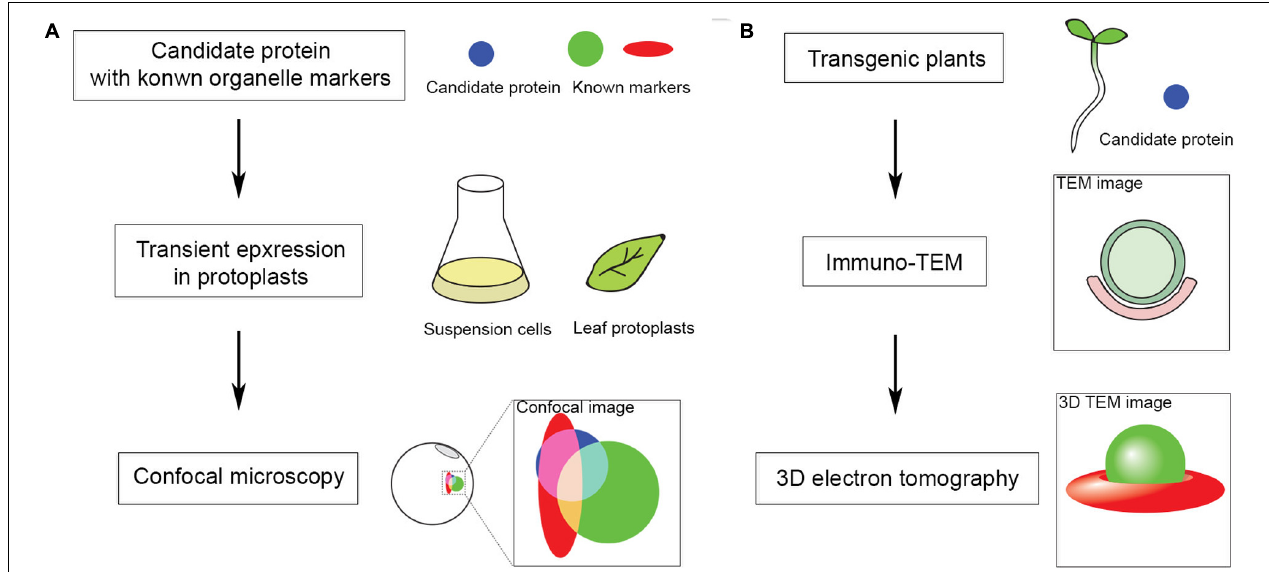
FIGURE 1 | Fast screening approach to identify protein candidates localized at organelle MCS for subsequent ultrastructural study in Arabidopsis. MCS markers are mostly unknown in Arabidopsis, hence, to start with: (A) Fluorescent tagged candidates are co-expressed with known organelle markers in Arabidopsis protoplasts for subsequent confocal imaging analysis. (B) Positive candidates identified in panel (A) are further transformed and expressed in transgenic Arabidopsis seedlings for subsequent immune gold-TEM and 3D electron tomographic (ET) analysis.